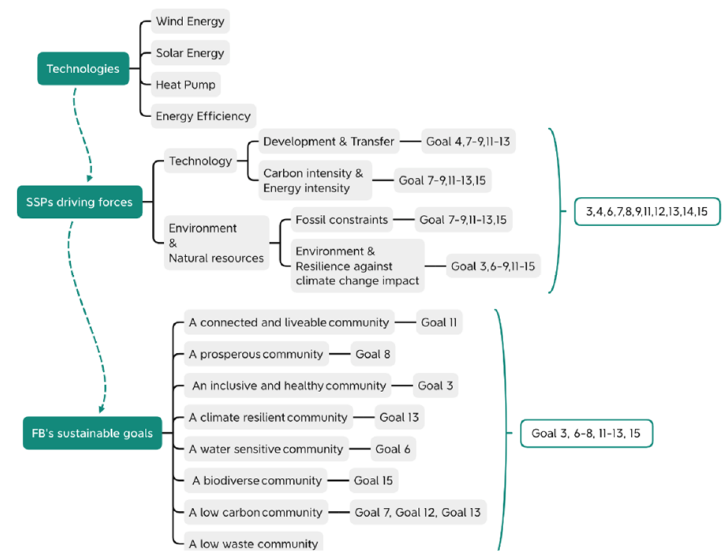
Figure 5. The mapping process.